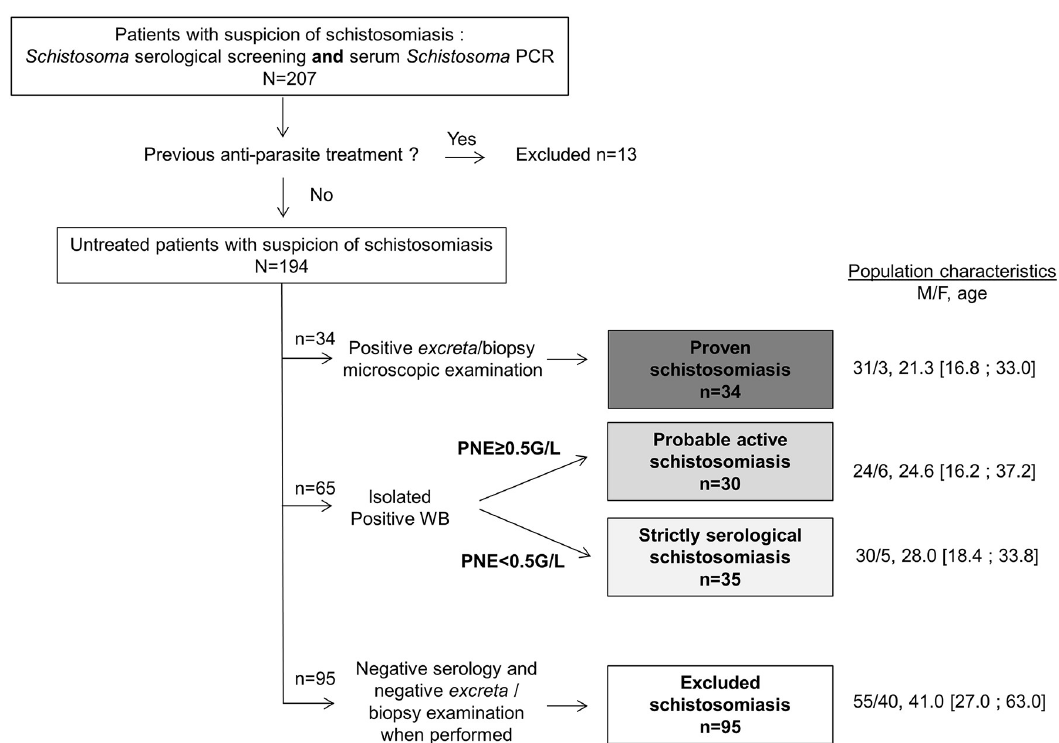
Fig 1. Flow chart for serum PCR evaluation. PNE: polynuclear eosinophil blood count.